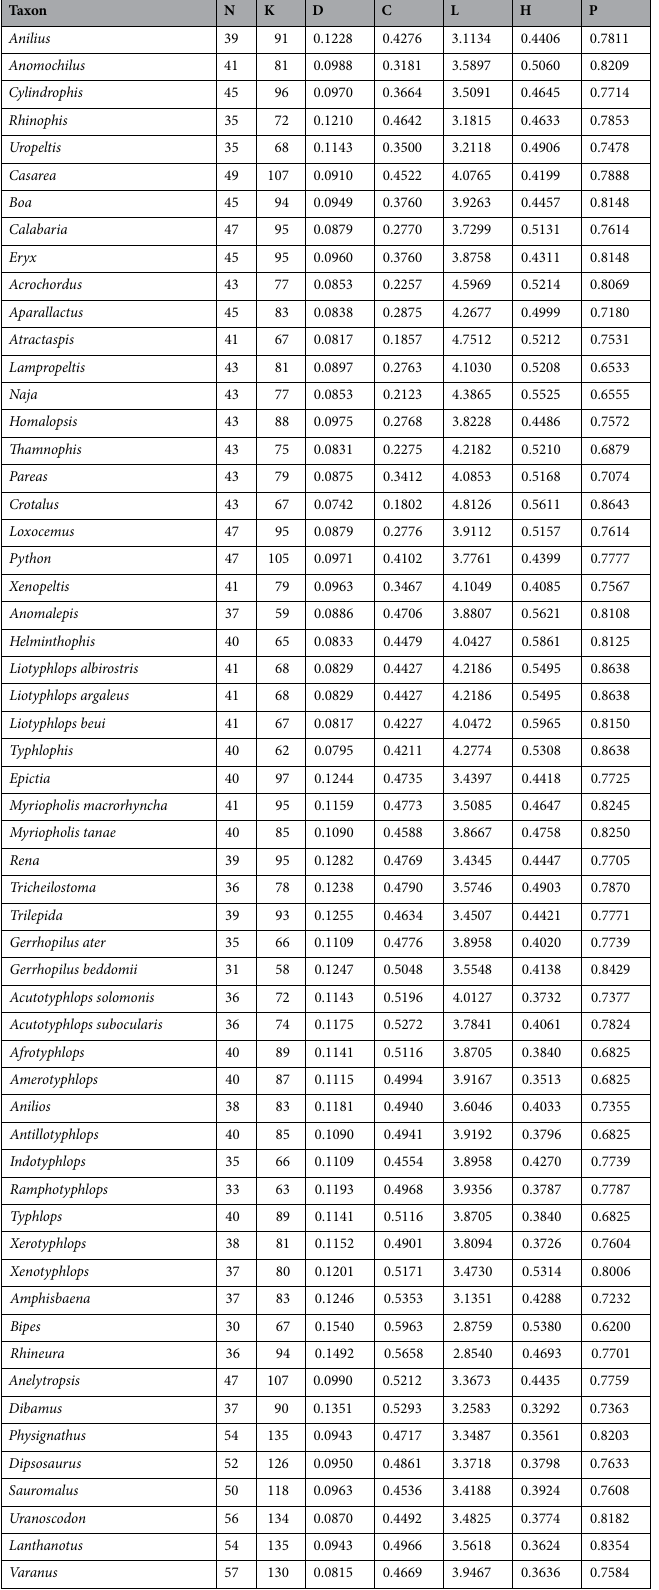
Table 1. Parameters calculated for each anatomical network. See “Methods” for explanation of parameters. N total number of nodes or elements, K total number of connections or articulations, D density of connections, C mean clustering coefficient, L mean shortest path length, H heterogeneity of connections, P